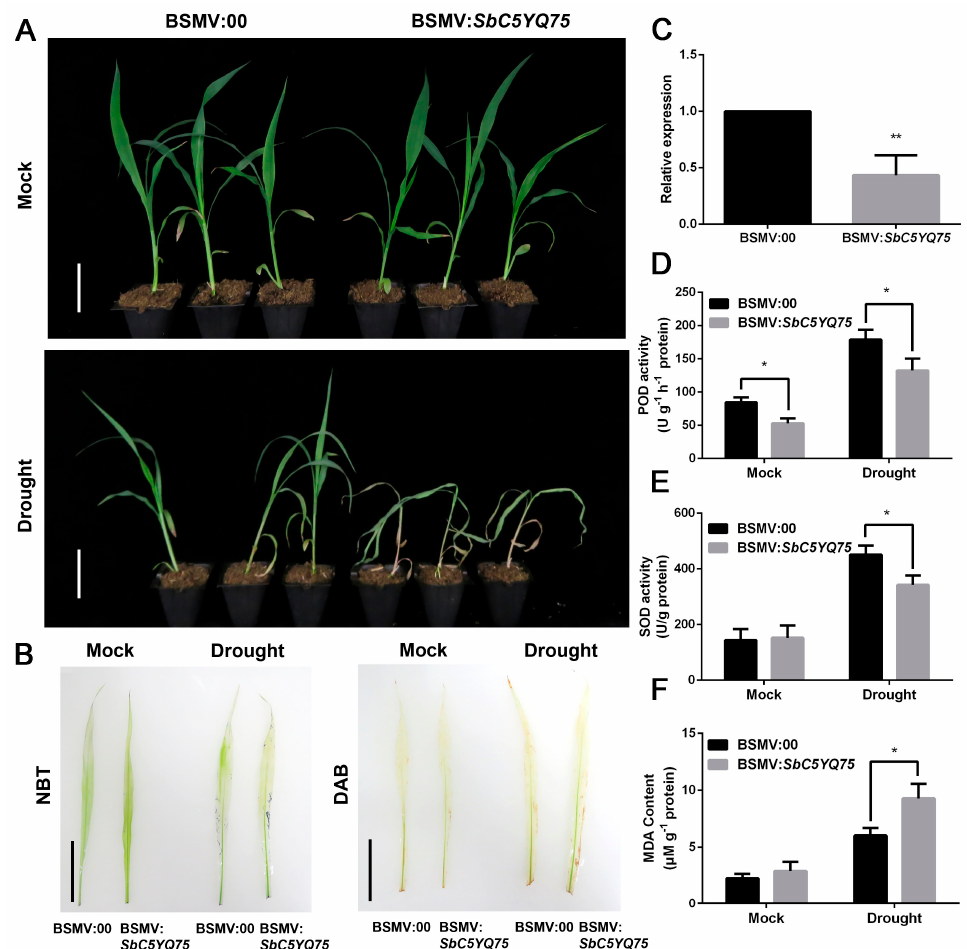
Figure 6. The function of SbC5YQ75 in response to drought stress in sorghum. ( A ) Phenotype of sorghum seedlings inoculated with BSMV:00 and BSMV: SbC5YQ75 under mock and drought-stress treatments. Bars indicate 6 cm. ( B ) DAB and NBT staining of leaves of sorghum seedlings inoculated with BSMV:00 and BSMV: SbC5YQ75 treated with drought stress for 5 days. Bars indicate 5 cm. ( C ) Relative transcript level of SbC5YQ75 in sorghum seedlings silenced by VIGS. SbEIF4A was used as the internal reference. Error bars indicate SD of three independent experiments. ** p < 0.01 by Student’s t -test. ( D – F ) POD and ( D ) SOD ( E ) activities and MDA content ( F ) in sorghum seedlings inoculated with BSMV:00 and BSMV: SbC5YQ75 under mock or drought-stress treatments. Error bars indicate SD of three independent experiments. * p < 0.05 by Student’s t ‐ test.